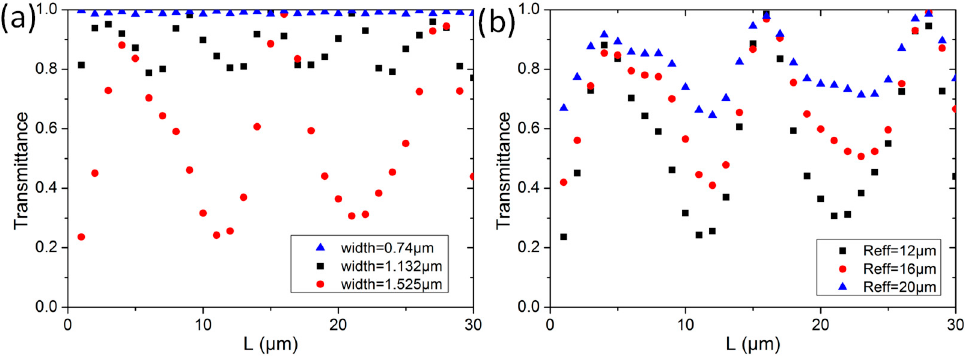
Figure 7. Simulation results of TE 1 mode ( a ) at different multimode bus waveguide widths and ( b ) at different effective Euler bend radii.